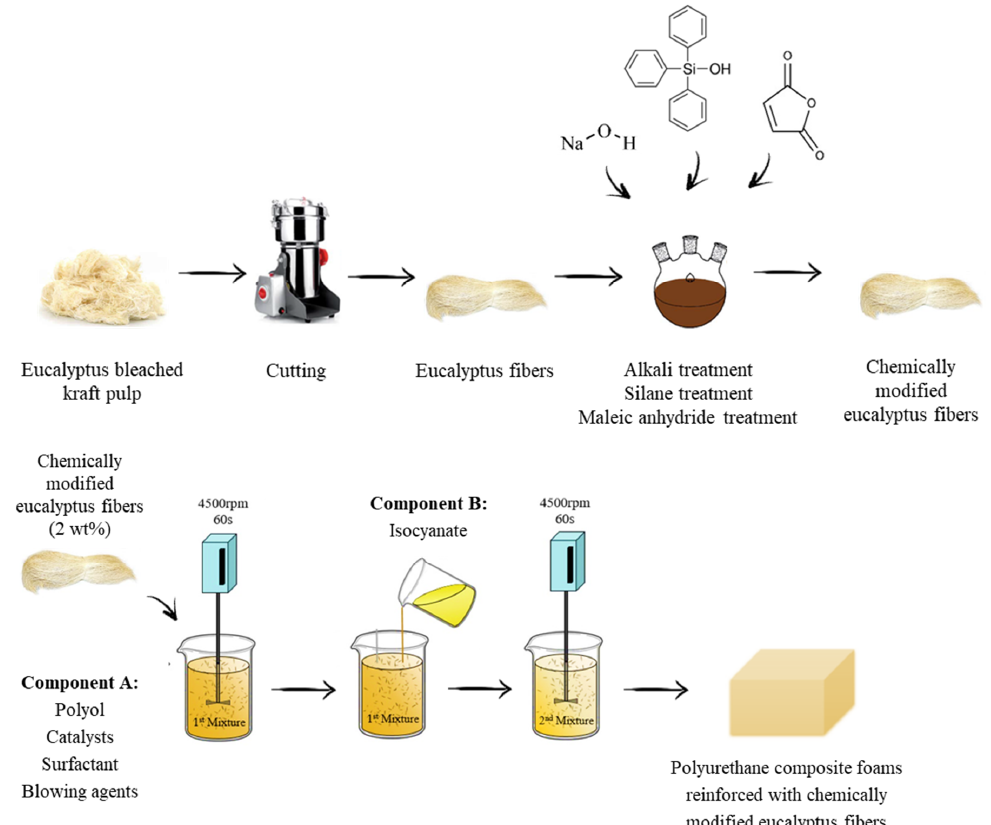
Figure 4. Schematic representation for the preparation of polyurethane foams modified with eucalyptus fibers.